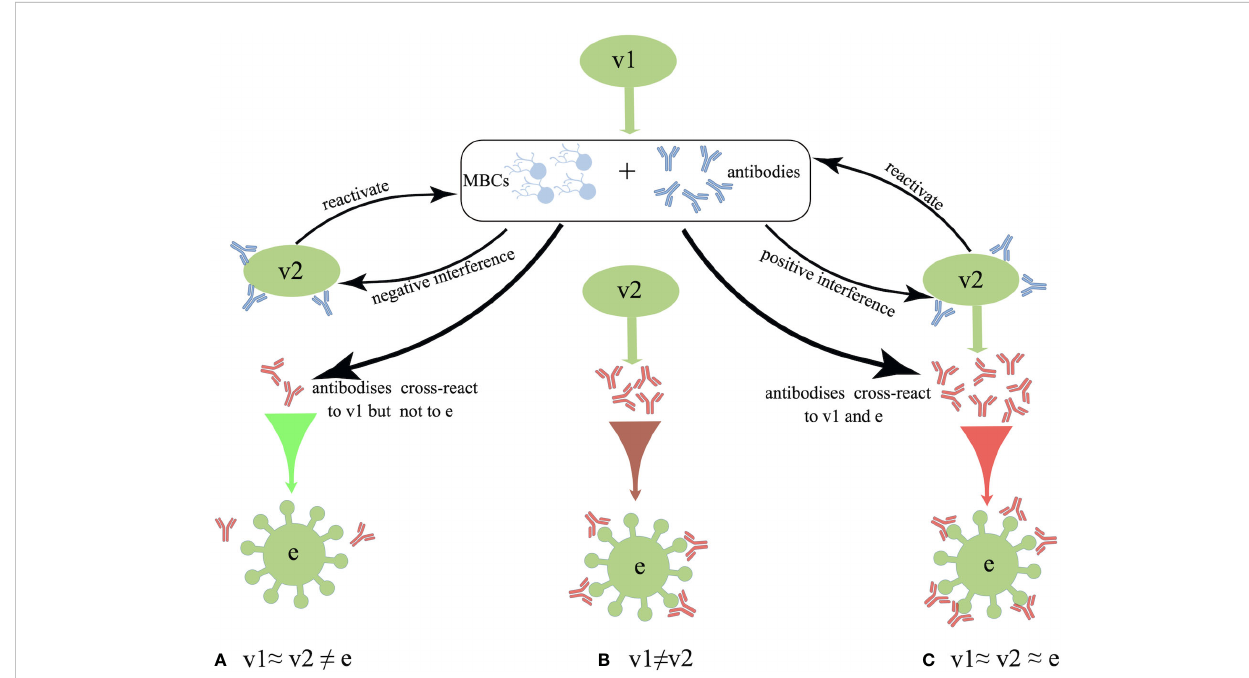
FIGURE 1 Schematic overview of the antigenic distance hypothesis (ADH). (A) Negative interference may occur if the antigenic distance between v1 and v2 is smaller, and that between v1 and endemic strain (e) strains is larger (i.e., v1 ≈ v2 ≠ e). (B) There should be no interference when v2 is antigenically distinct from v1 (i.e., v1 ≠ v2). (C) Positive interference may occur when the antigenic distances among v1, v2, and e are relatively small, as these antibodies could react to all three strains (i.e., v1 ≈ v2 ≈